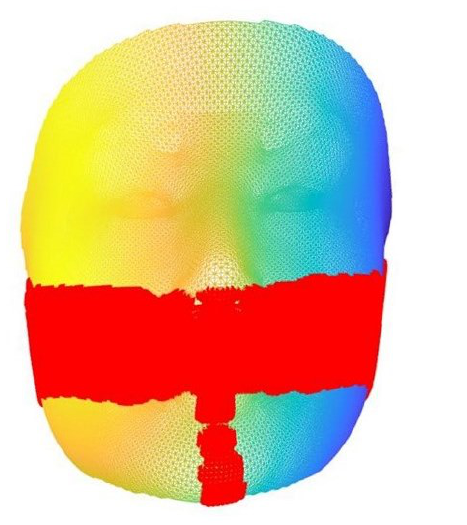
Figure 3. Automatic landmark selection by the Euclidean Distance